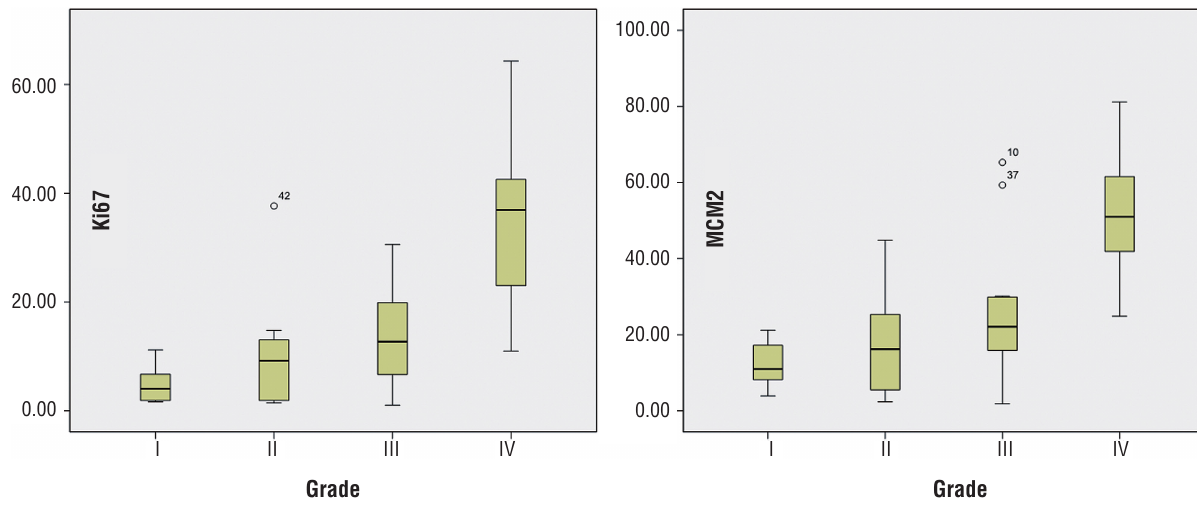
figure 2 - stem and Leaf graphs showing relationship of grade with Labeling index for Ki-67 and McM-2. note that although there is significant overlap in the LI between grades, the mean is increasing. Black central line (median), Boxes (interquartile ranges) and ranges are enclosed by lines. The outlying cases are shown by